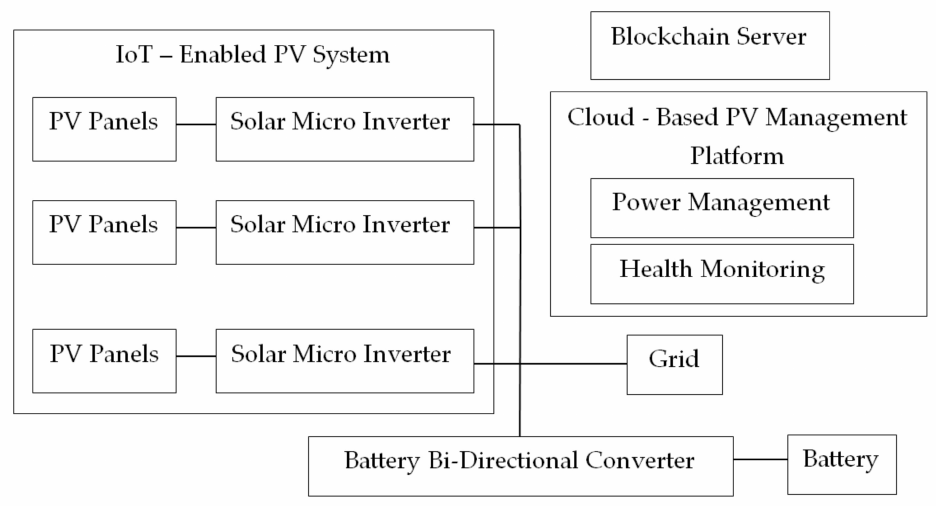
Figure 9. Architecture of IoT-enabled PV